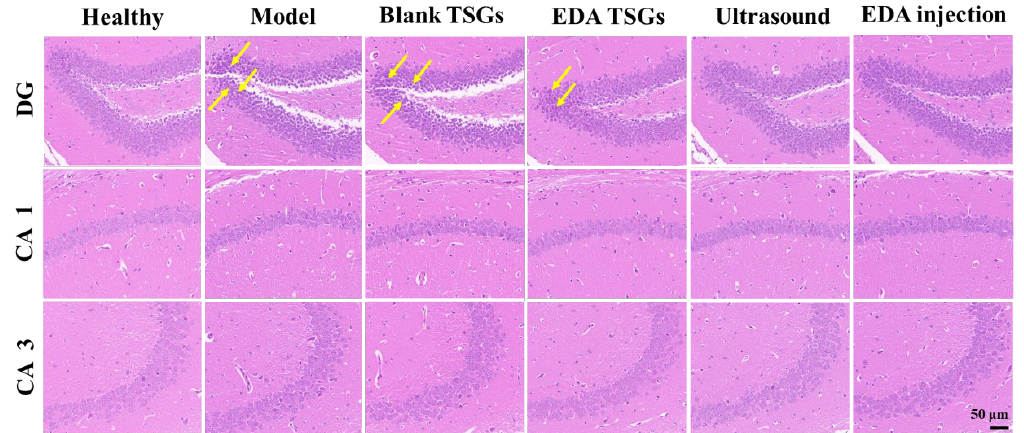
Figure 11. H.E staining of the hippocampus in each group. Scale bar = 50 μ m. The yellow arrows represent the nuclear pyknosis and hyperchromatism parts of neurons. represent the nuclear pyknosis and hyperchromatism parts of